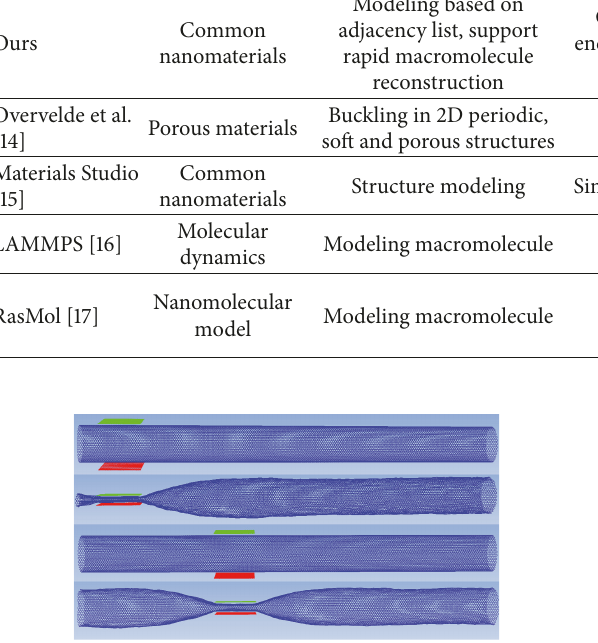
Figure 31: Simulation for carbon nanotube compression.